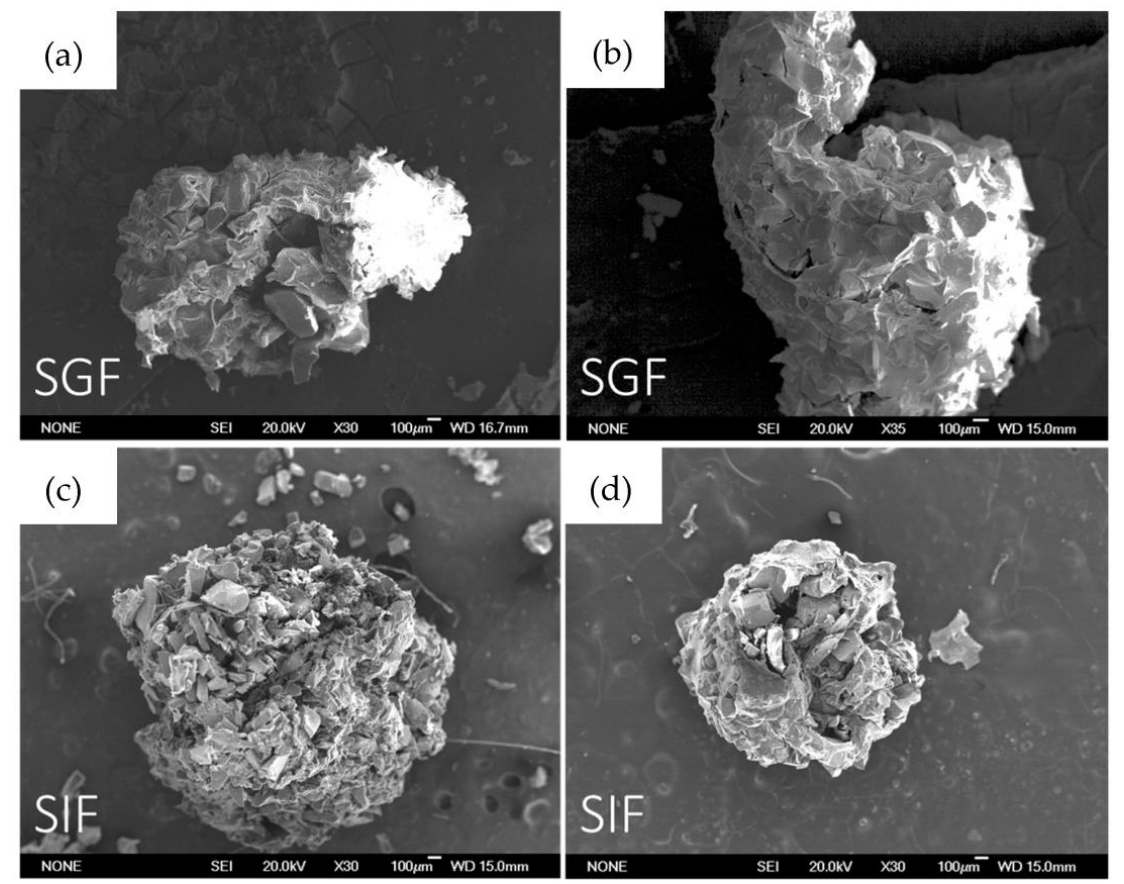
Figure 9. SEM images in order: ( a ) B-MG_curc5 after 4 h soaking in SGF; ( b ) B-MG_5.0_curc5 after 4 h soaking in SGF; ( c ) B-MG_curc5 after 4 h soaking in SIF; and ( d ) B-MG_5.0Ce_curc5 after 4 h soaking in SIF.